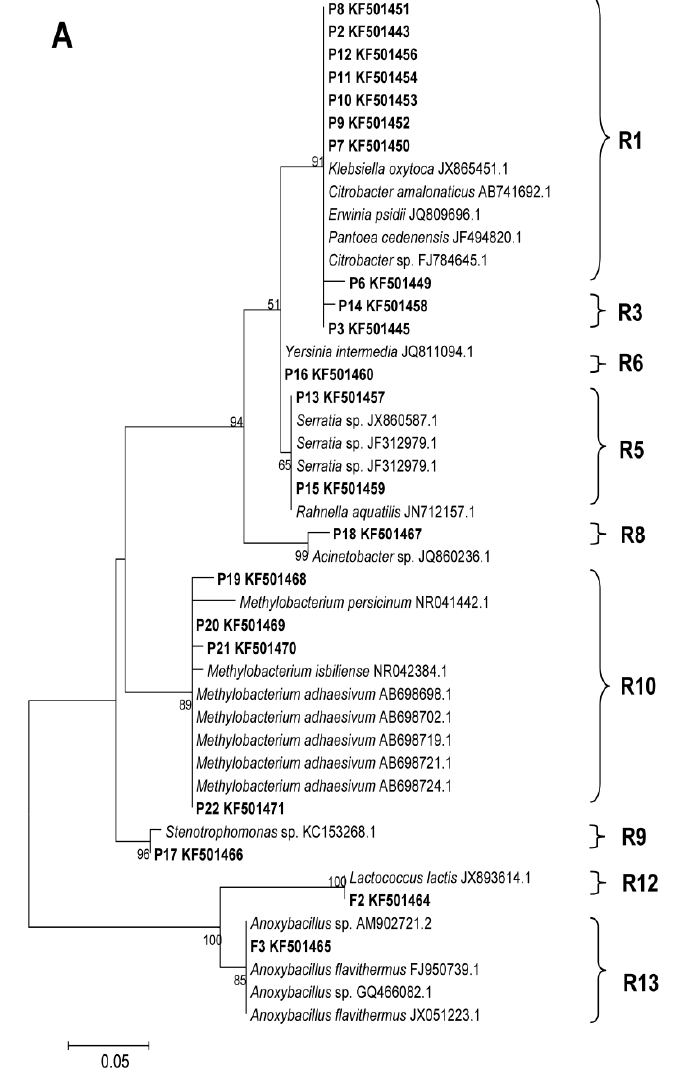
Figure 2. Phylogenetic trees of the bacterial communities in the gut of Dendroctonus armandi based on the 16S rRNA gene fragments. ( A ) Maximum likelihood phylogenetic tree of the bacterial community in the guts of larvae and pupae using the model Jukes-Cantor + I model; ( B ) Neighbor-joining phylogenetic tree of the bacterial community in the guts of female and male adults using the Kimura 2-parameter + G model. R1–R13 represent different operational taxonomic units with a 3% sequence dissimilarity cut-off (OTUs ) cluster obtained with 0.03